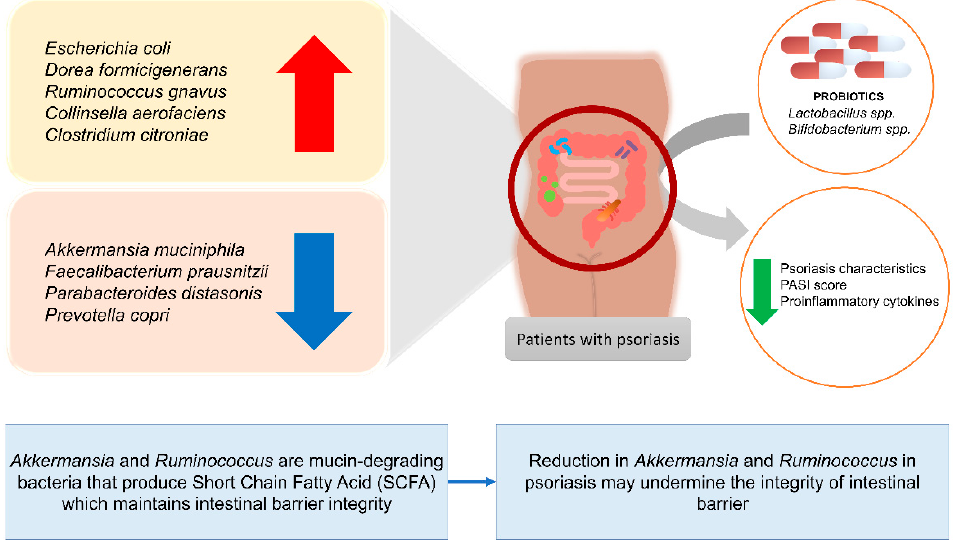
Figure 2. Changes in the abundance of specific bacteria species in patients with psoriasis and the effects of certain probiotic strains on patients with psoriasis.